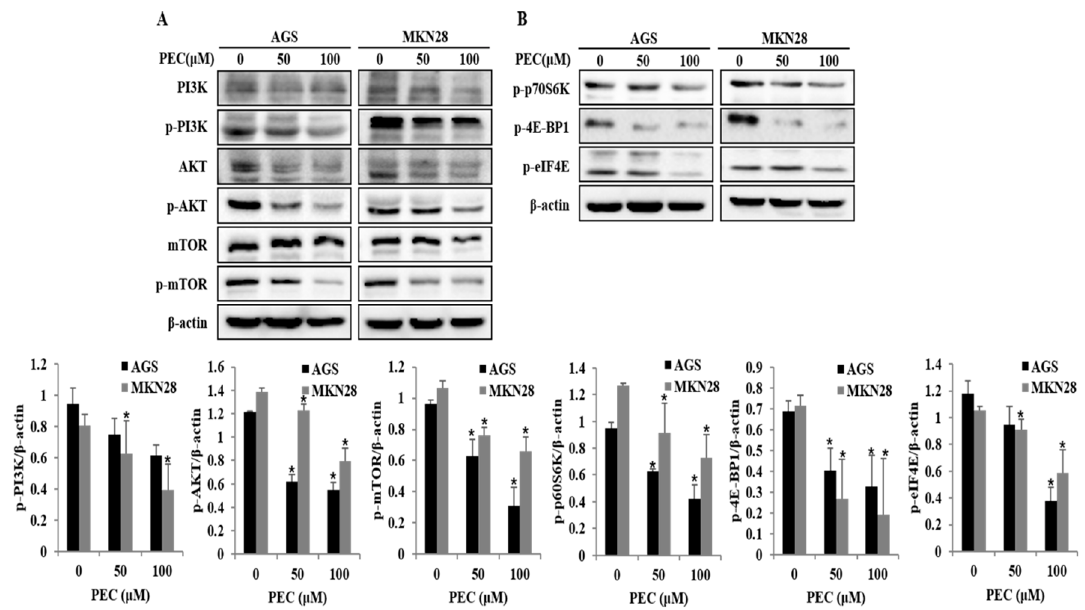
Figure 6. Effect of PEC on inhibition of PI3K/AKT/mTOR pathway. ( A , B ) AGS and MKN28 were treated with indicated concentrations of PEC or 24 h. The cell lysates were subjected to SDS-PAGE and analyzed by immune-blotting. Densitometry analyses of p-PI3K, p-AKT, p-mTOR, p-p70S6K, p-4E-BP1 and p-eIF4E protein expressions are presented as the mean ± standard deviation (SD) of at least three independent experiments. Statistical differences were analyzed with Student’s t -test (* p < 0.05 vs. control).